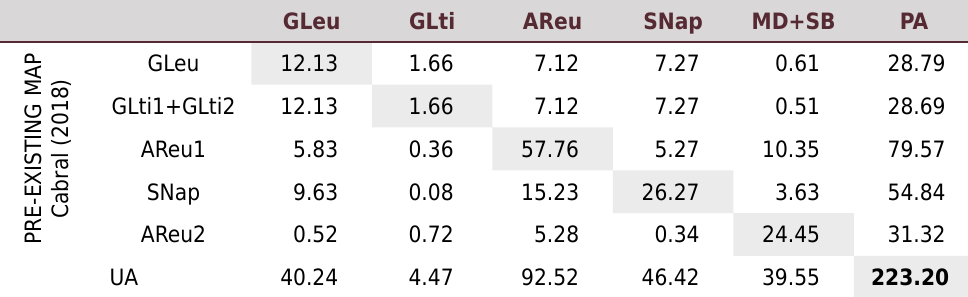
Table 6. Confusion matrix of the comparison between mapping 1 and the traditional mapping GLeu GLti AReu SNap MD+SB